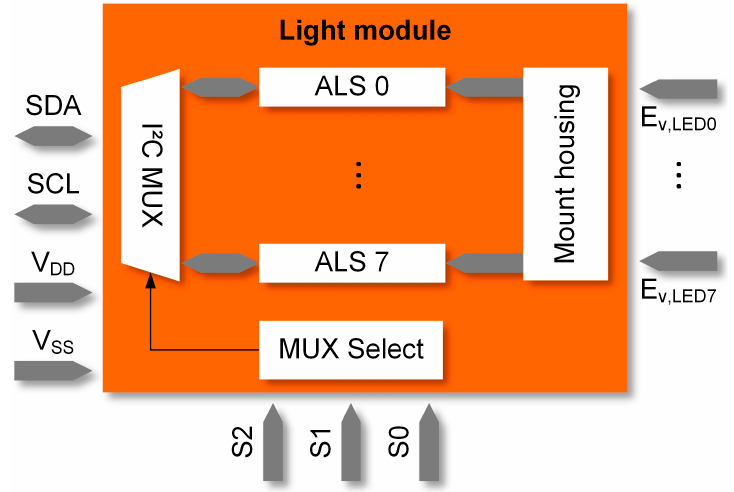
Figure 9. Block diagram of the light module.